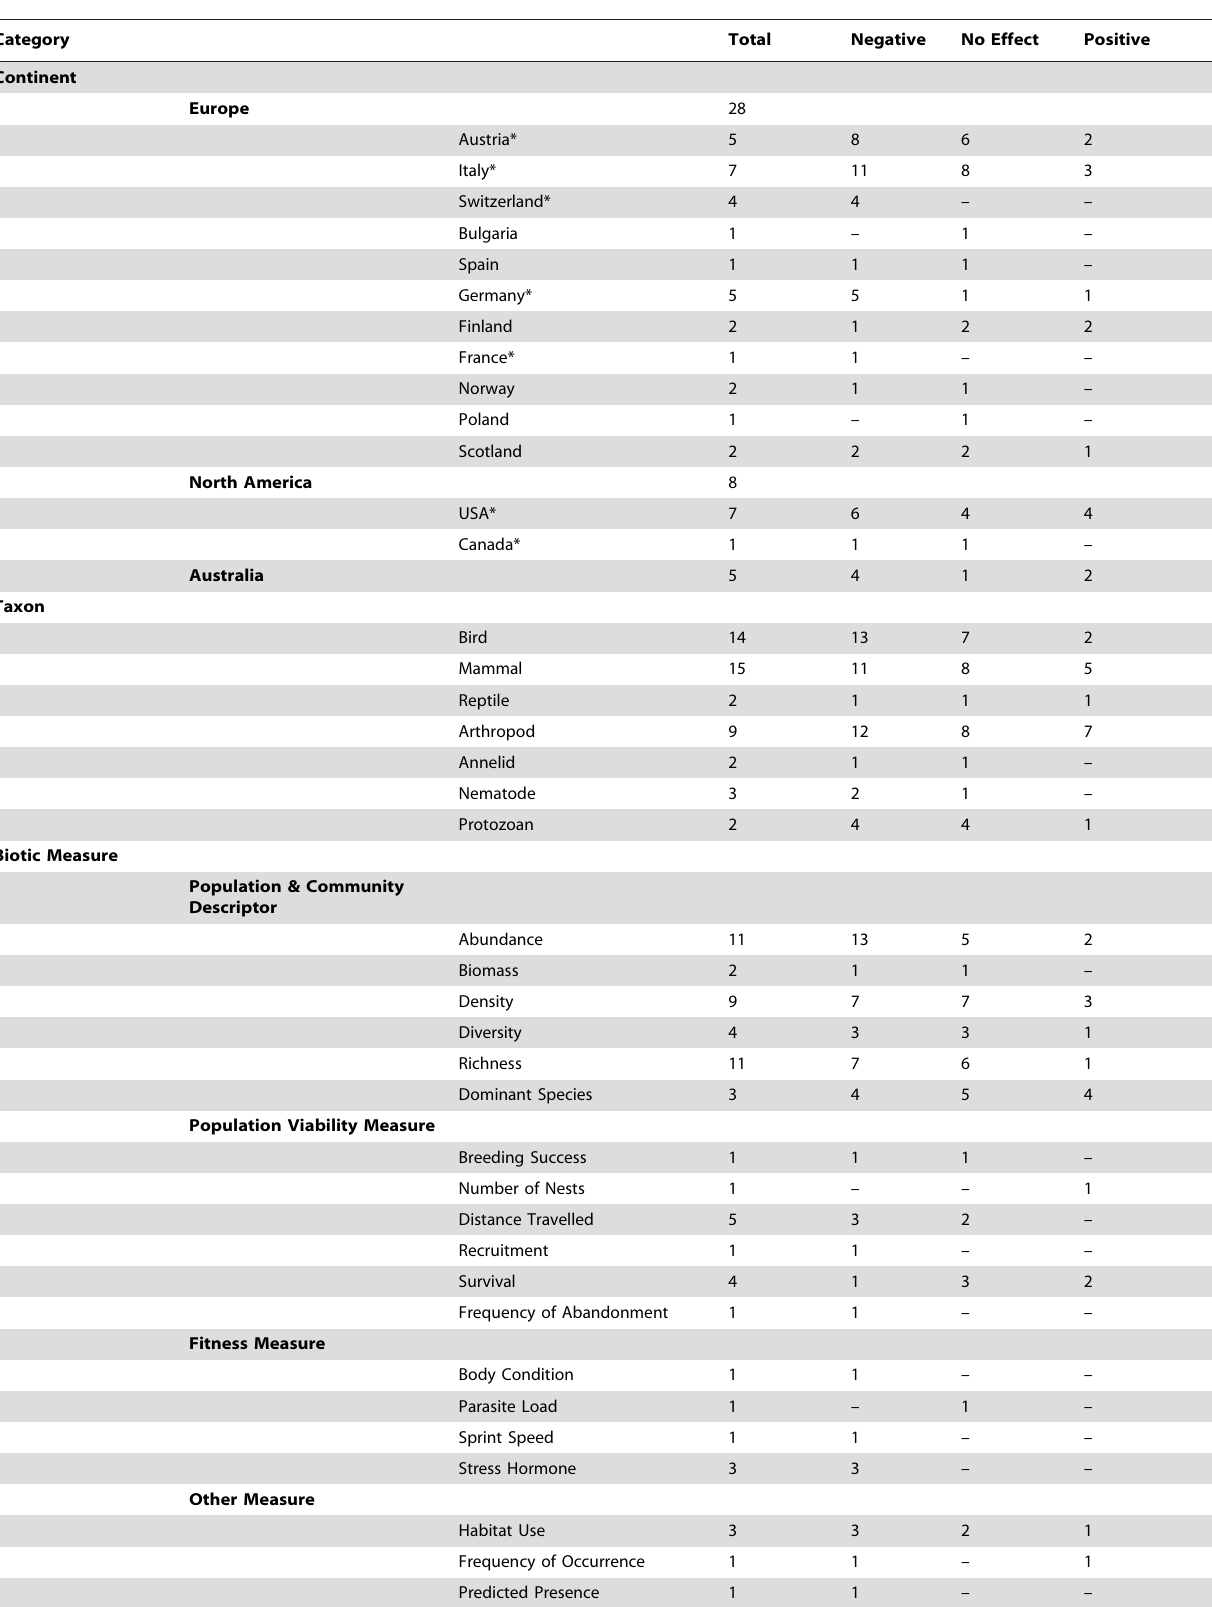
Table 2. Numbers of published studies that investigated the impacts of winter recreation on wildlife.